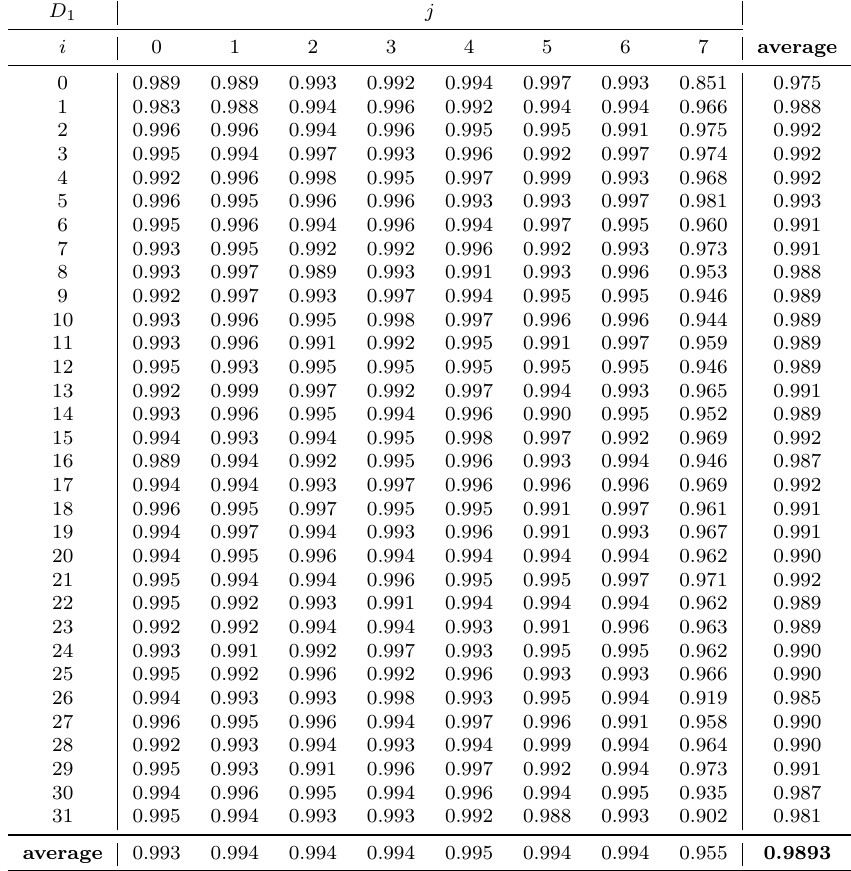
Table 13: Empirical probability to recover the message bit m [8 i + j ] from a single trace using POL2MSG() . Average results for 1K traces from device D 2 . D